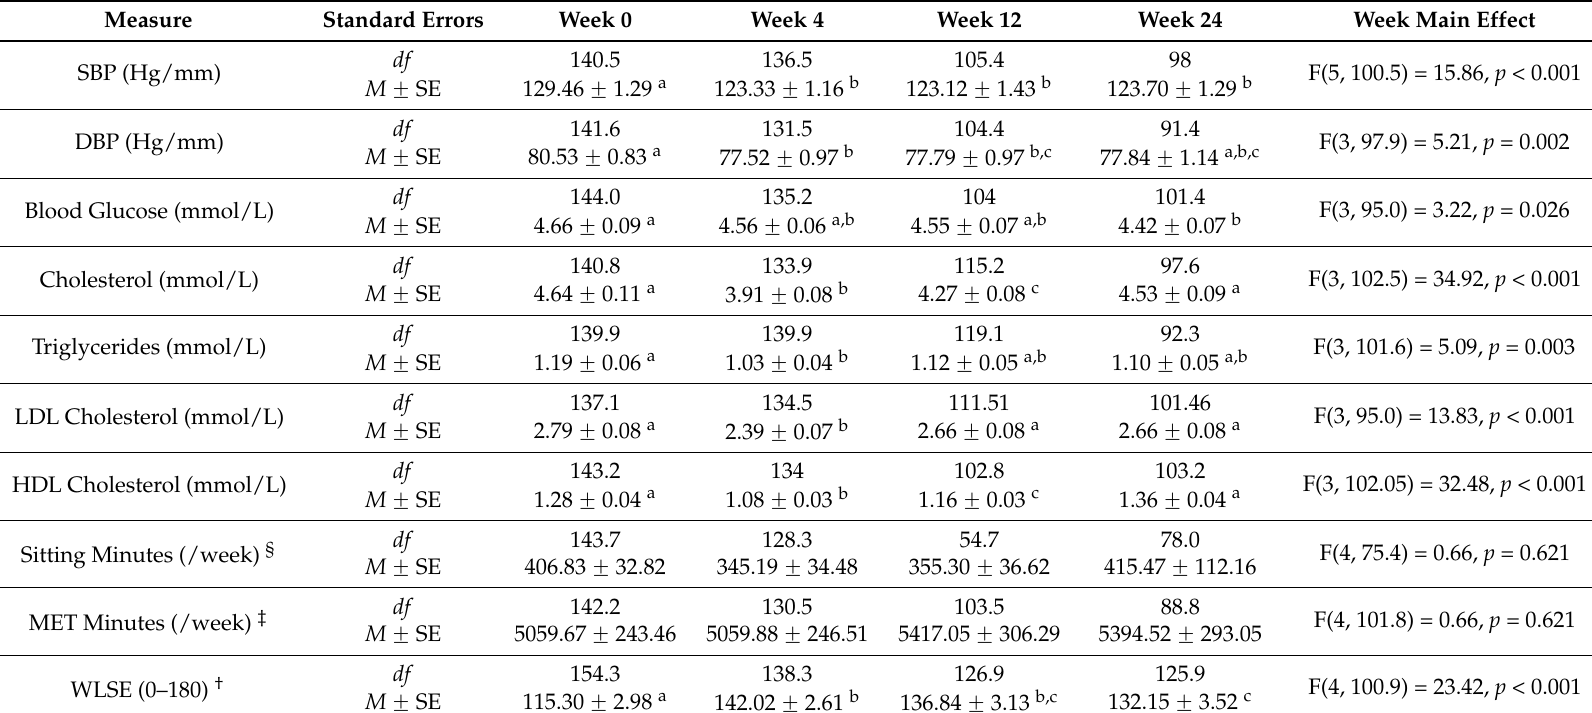
Table 2. Adjusted means with standard errors ( M ˘ SE) based on mixed models for study measures reported by study week and main model effects for